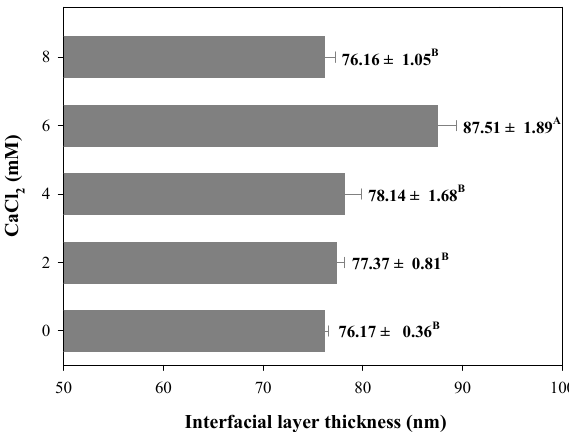
Figure 4. Interfacial layer thickness of freshly prepared filled hydrogels containing different CaCl 2 levels. The different letters (A, B) represent significant differences among filled hydrogels at different CaCl 2 levels ( p < 0.05).